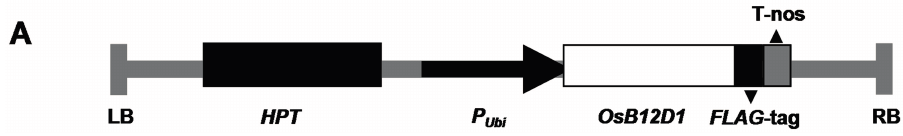
Figure 4. Overexpressing of OsB12D1 enhanced rice seed flooding